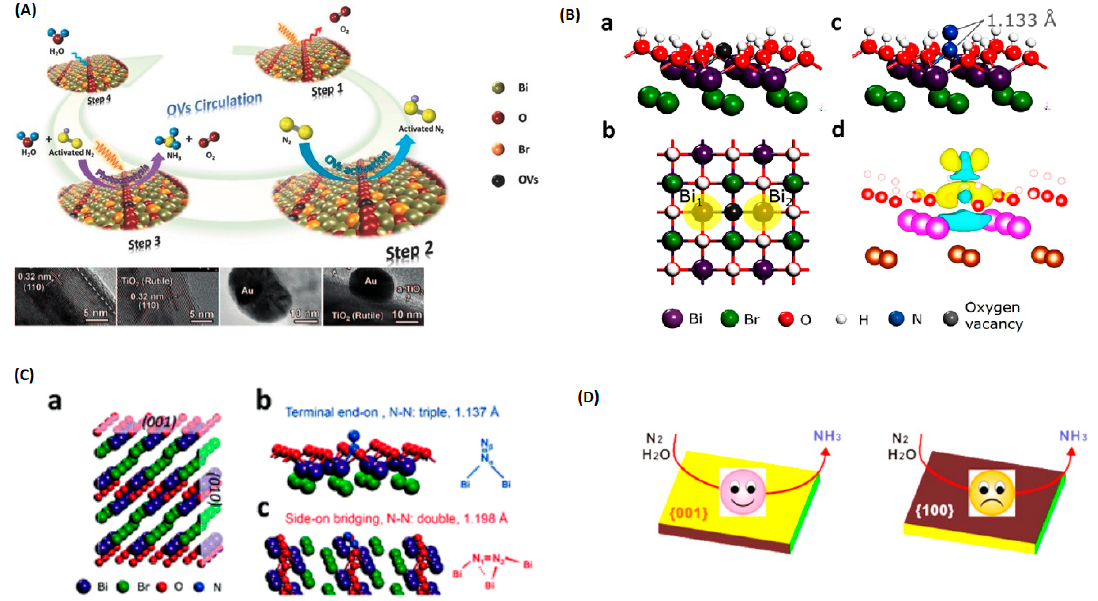
Figure 10. ( A ) Schematic illustration of the photocatalytic N 2 fixation model in which water serves as both the solvent and proton source, as well as the reversible creation of light - induced oxygen vacancies; ( B ) Theoretical prediction of N 2 activation on the OV of BiOBr (001) surface. (a) Side and (b) top view of (001) surface of BiOBr with an OV. (c) The adsorption geometry of N 2 on the OV of BiOBr (001) surface. (d) The charge density difference of the N 2 -adsorbed (001) surface; ( C ) Adsorption of N 2 on the (001) and (010) facets of BiOCl. (a) Crystal structure of BiOCl and the corresponding cleaved (001) and (010) surface. (b) The terminal end-on adsorption structure of N 2 on (001) surface of BiOCl and (c) the side-on bridging adsorption structure of N 2 on (010) surface of BiOCl; ( D ) Schematic illustration of the photocatalytic N 2 fixation over Bi 5 O 7 I (001) and (100) facers. (Reproduced with permission from the respective publishers; Figure 10A, Figure 10B, Figure 10C and Figure 10D from the References [55], [31], [59], and [60], respectively).